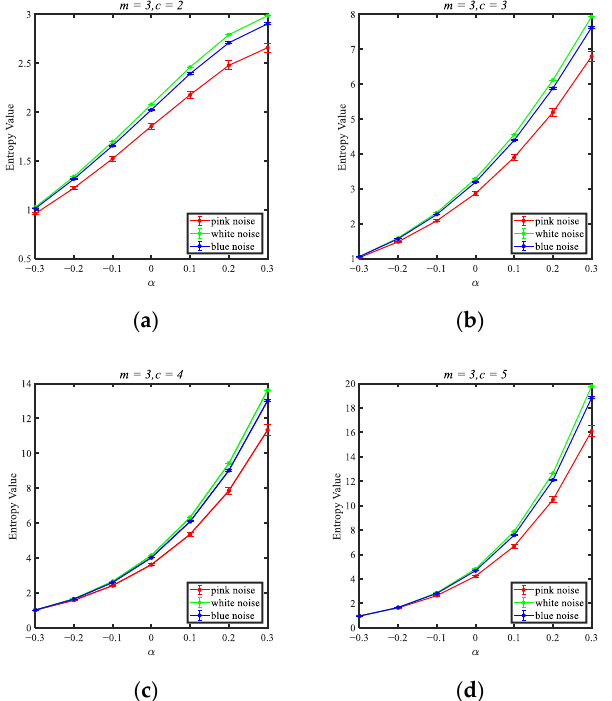
Figure 2. Means and standard deviations of different class number 𝑐 at different fractional orders. ( a ) 𝑐 = 2; ( b ) 𝑐 = 3; ( c ) 𝑐 = 4; ( d ) 𝑐 = 5.